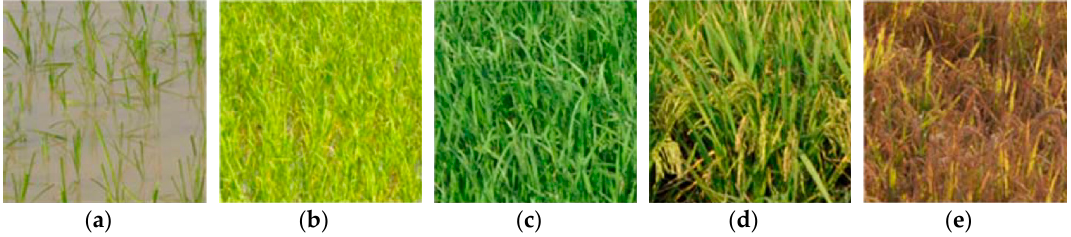
Figure 8. Five different growth stages of paddy: ( a ) stage of tillering; ( b ) stage of stem-elongation; ( c ) stage of panicle-exsertion; ( d ) stage of flowering; and ( e ) stage of ripening.